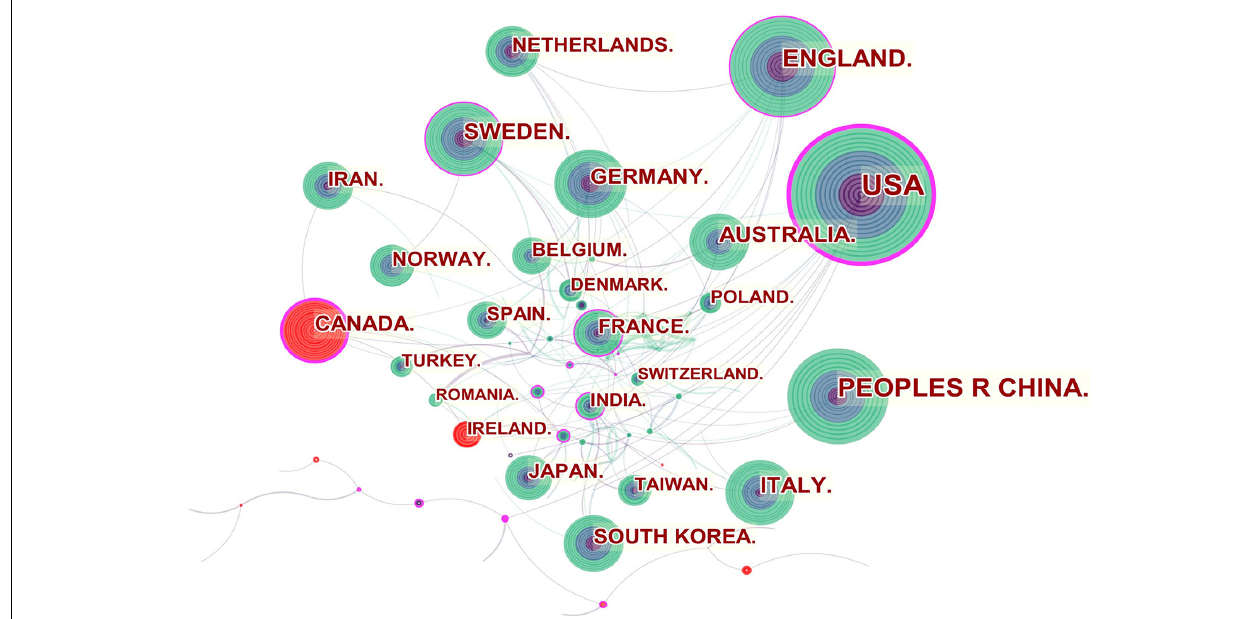
FIGURE 2 | Network of countries and regions engaged in IBS research.